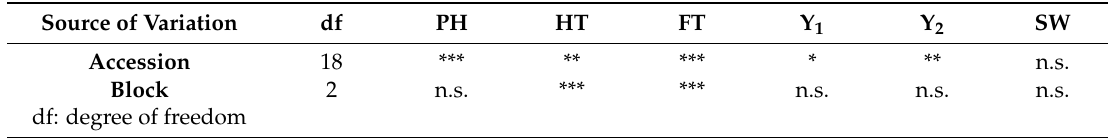
Figure 2. Apulian kale phenotype with indented leaves. Table 3. Analysis of variance (ANOVA) for plant height (PH), first harvesting time (HT), flowering time (FT), edible yield per plant at the first two harvests (Y 1 and Y 2 ), and 1000 seed weight (SW) in the Apulian kale germplasm collection under